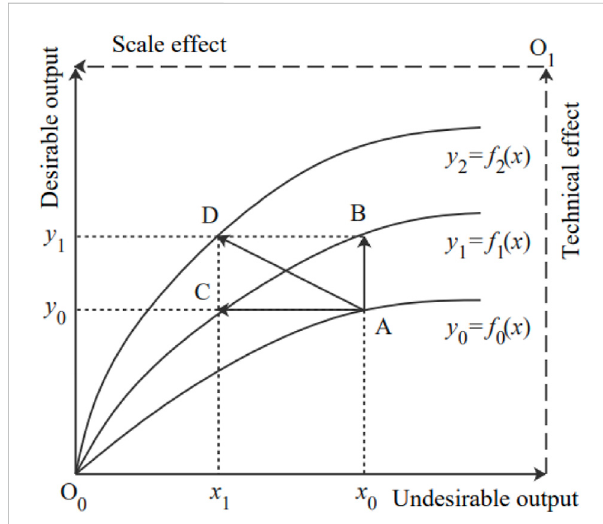
FIGURE 1 Mechanism of high-tech industry agglomeration on green innovation ef fi